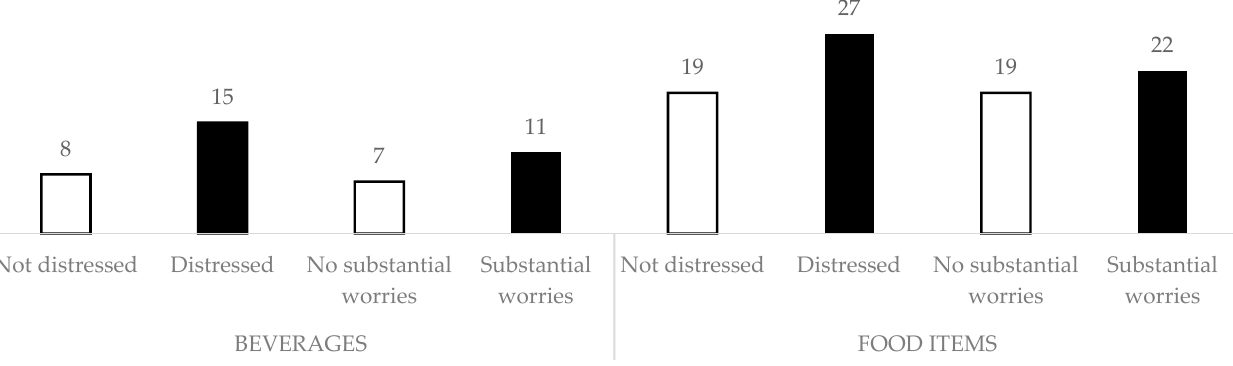
Figure 2. Proportions (%) of participants reporting frequent intake of high-sugar beverages ( left ) and food items ( right ), comparing those with psychological distress and substantial COVID-19-related worries with those that were not distressed and not worried. Differences were determined to be statistically significant by means of a Pearson’s Chi Square test ( p < 0.05). Frequent consumption is defined as a self-reported intake above 3 times per week.